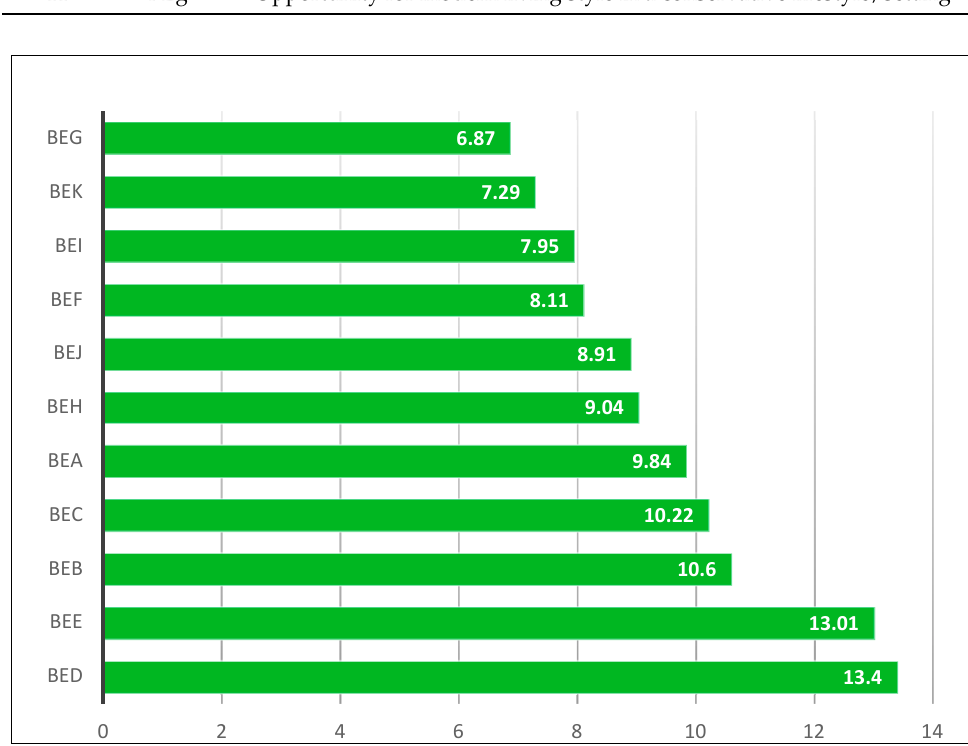
Figure 3. Ranking profile of the beneficial factors. Table 4. List of beneficial factors in ranked order.